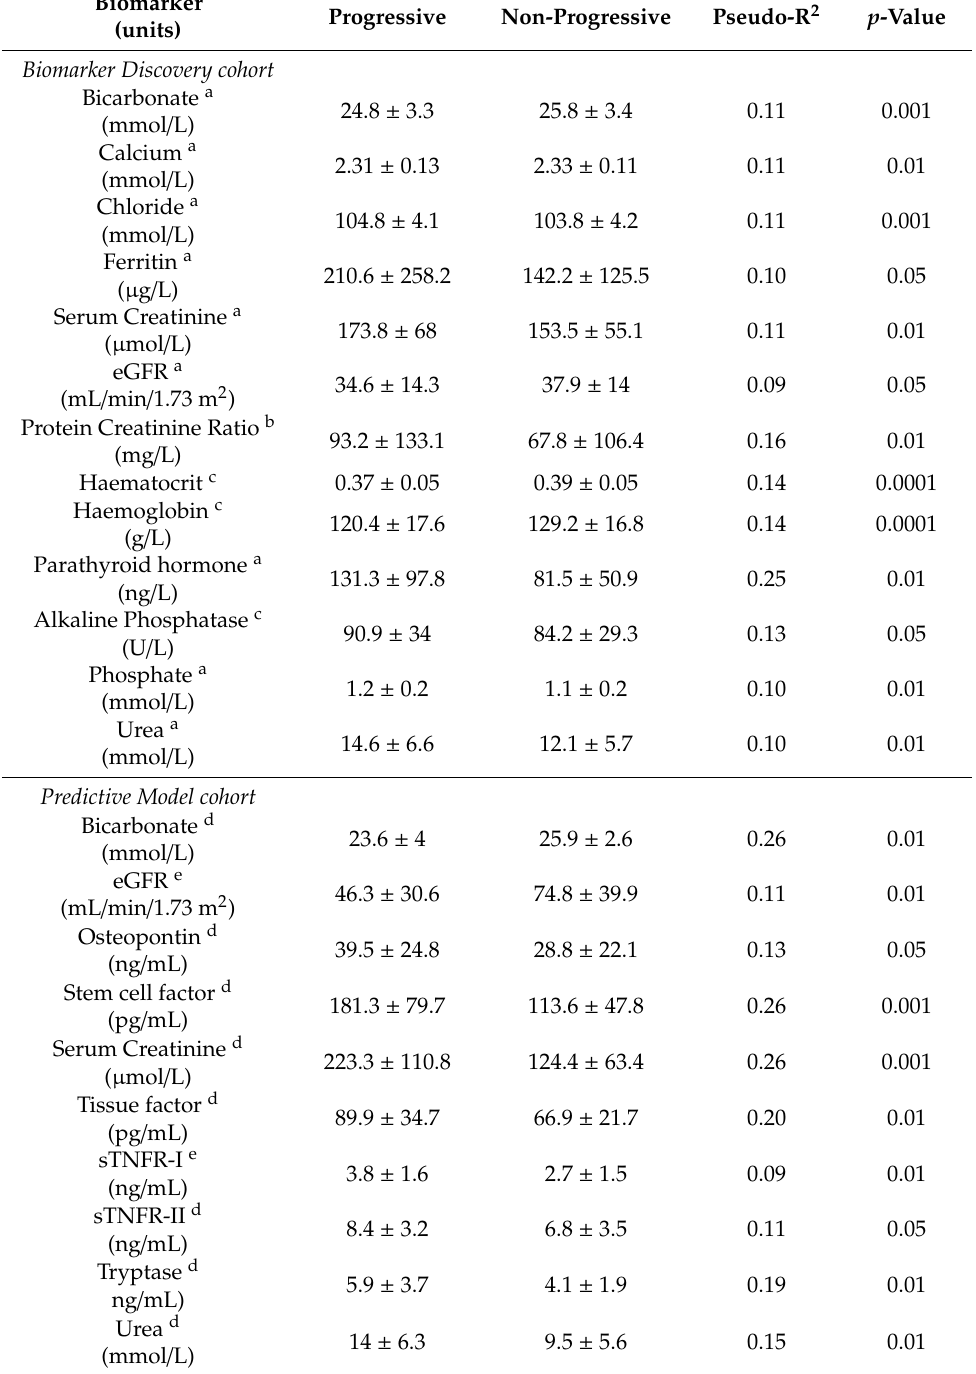
Table 2. Biomarkers that di ff er between progressive and non-progressive CKD